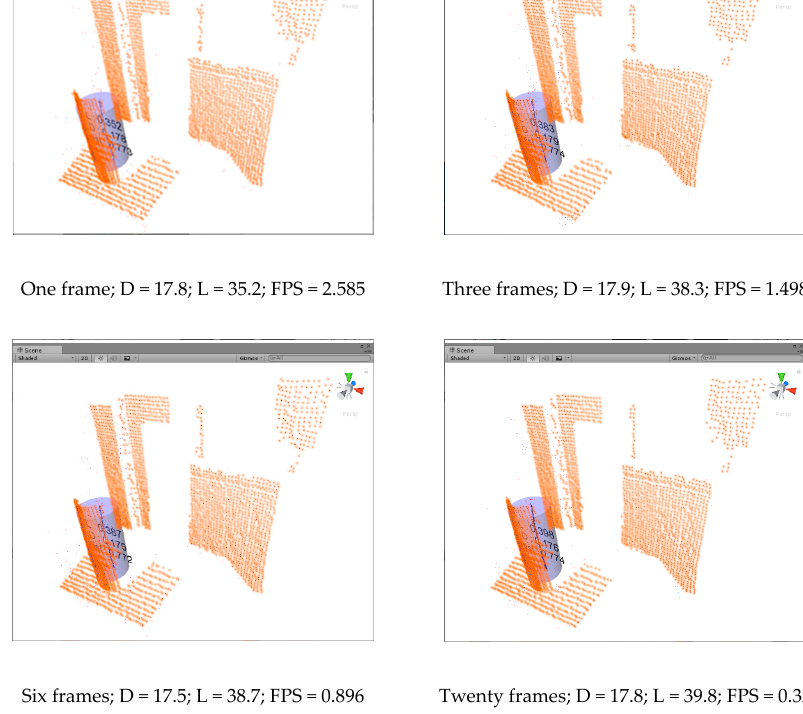
Figure 16. Real-time cylinder estimation using multiple (6) cores (cm).